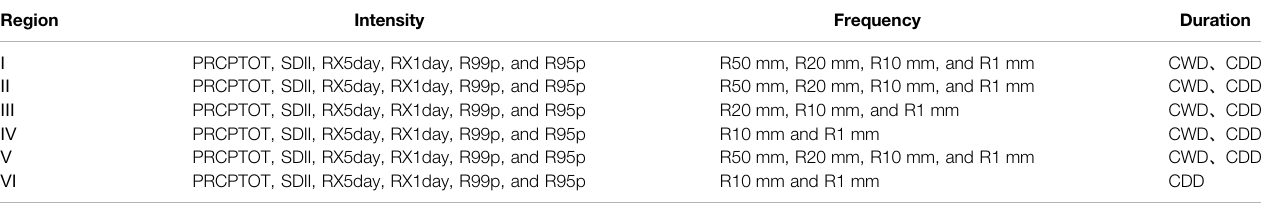
TABLE 3 | Extreme precipitation indices for six regions over China. Region Intensity